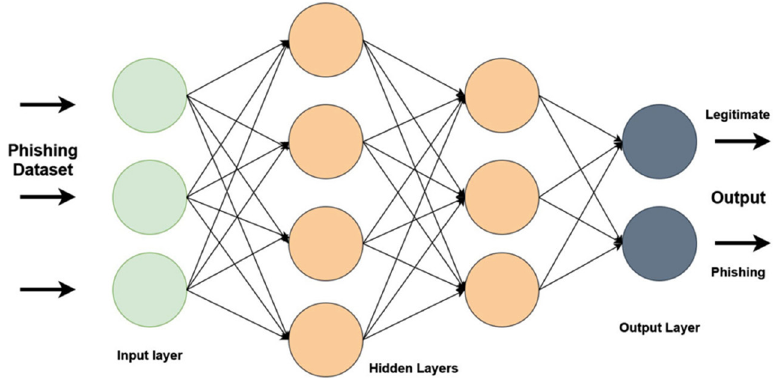
Figure 5. Deep learning for phishing